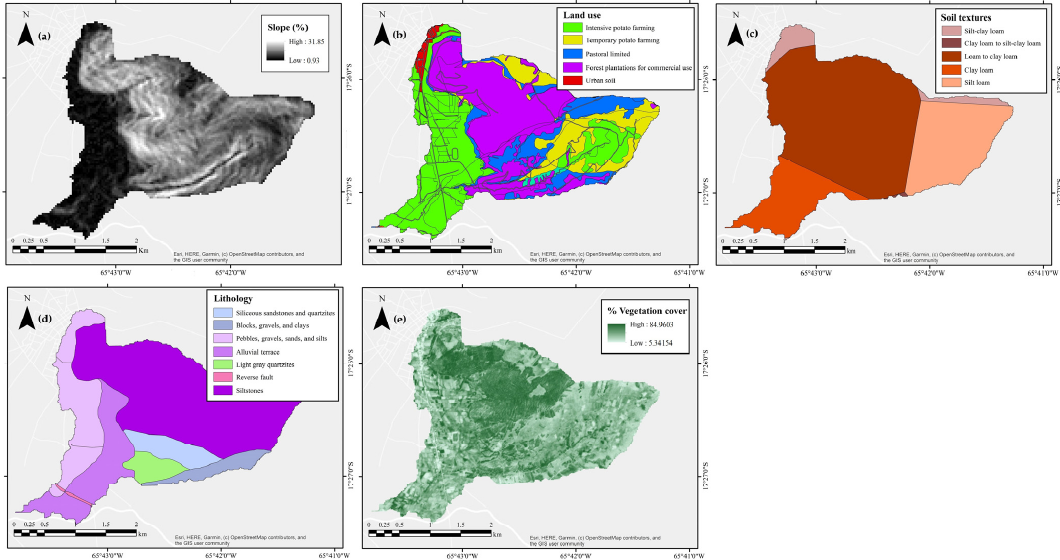
Figure 4. Input maps utilized for applying the Matus et al. [46] model: ( a ) slope map, ( b ) land use map, ( c ) soil textural map, ( d ) lithological map, ( e ) map of % of vegetation cover.